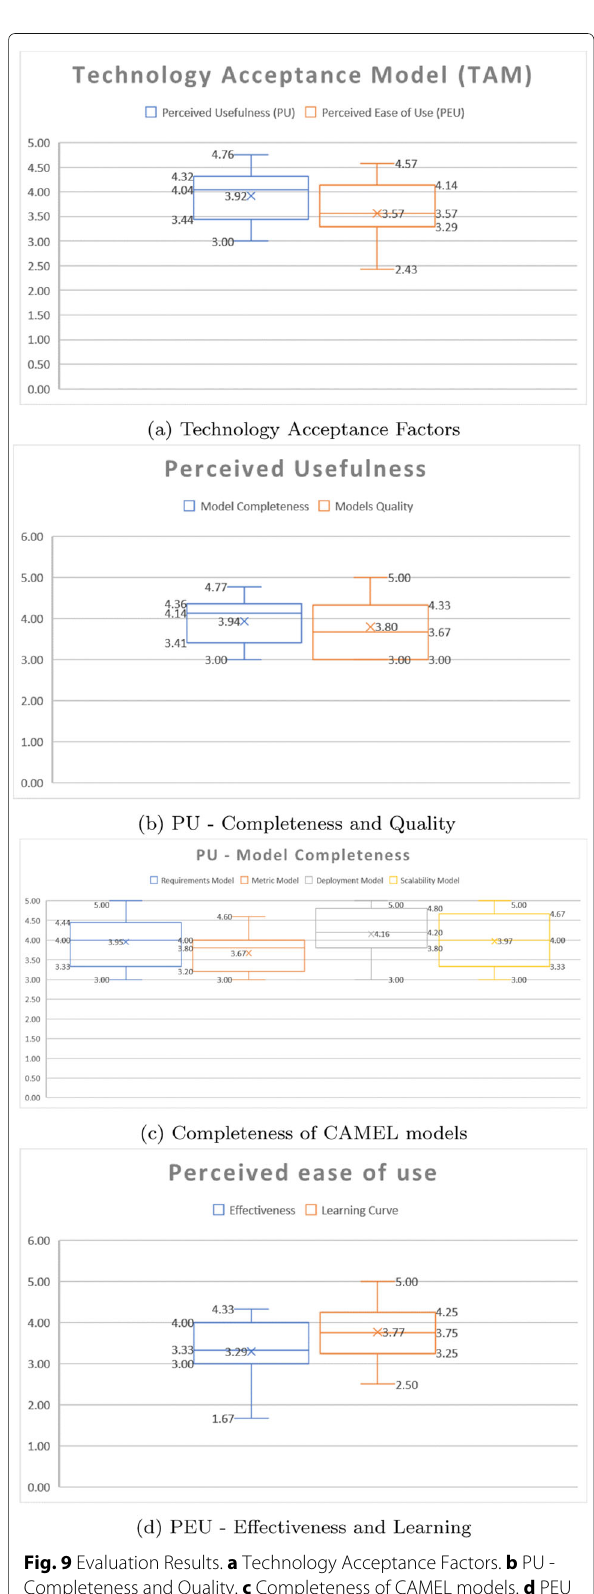
Fig. 9 Evaluation Results. a Technology Acceptance Factors. b PU - Completeness and Quality. c Completeness of CAMEL models. d PEU - Effectiveness and